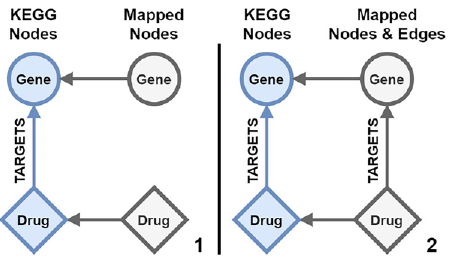
Figure 6: Trivial edge mapping between twomapped datasource nodes.